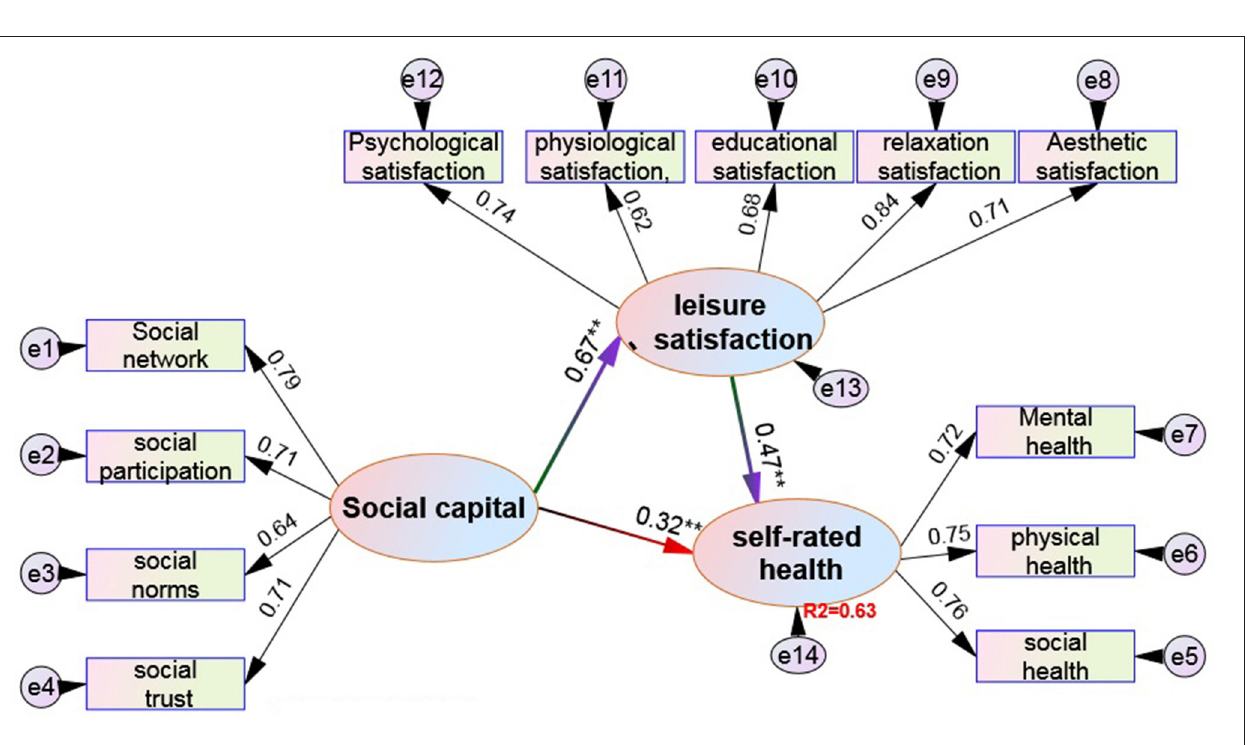
FIGURE 3 | Validation of the relationship model between social capital, leisure satisfaction, and self-rated health. “* , **, and ***” represent the significant levels of 0.05, 0.01, and 0.001,